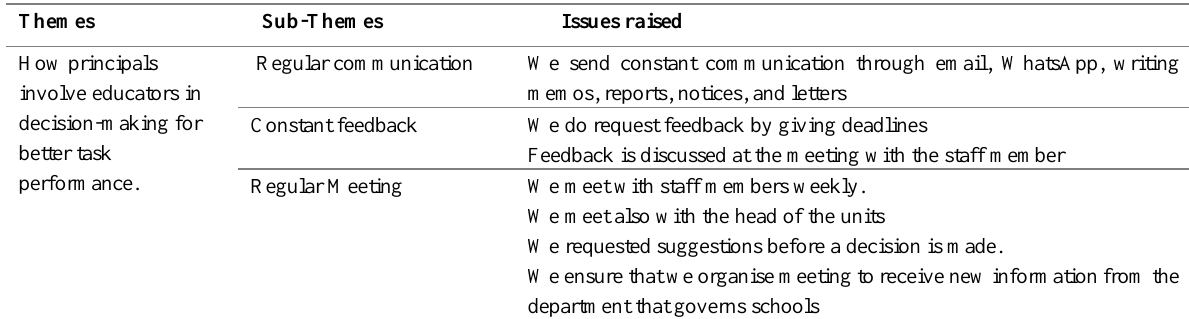
Table 3 : Themes and sub-themes concerning how principals involve educators in decision-making for better task